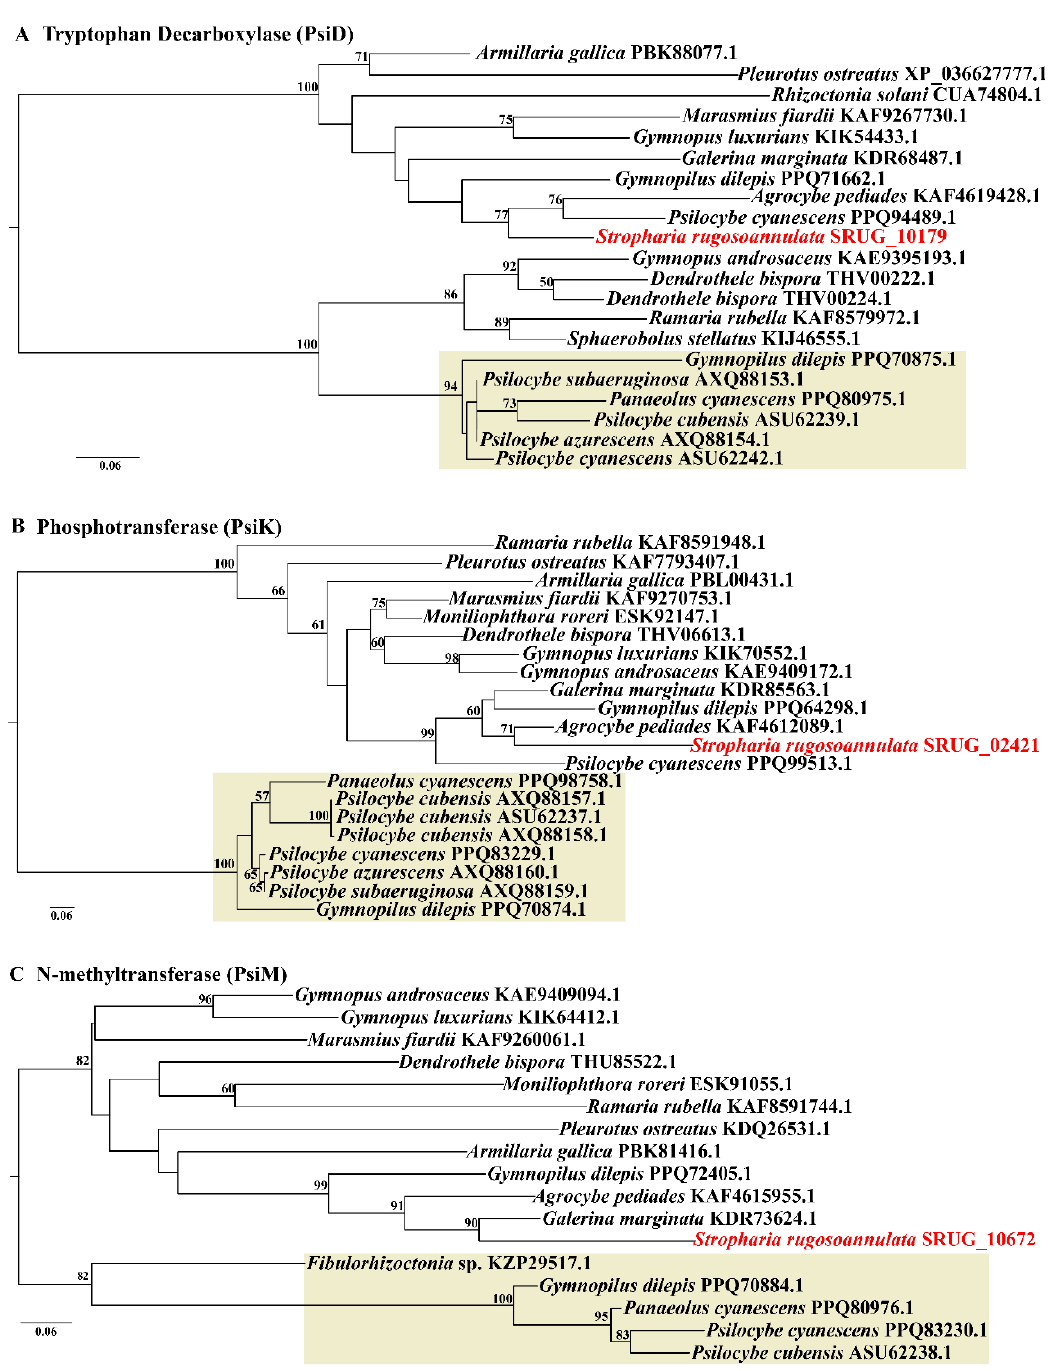
Figure 6. RAxML phylogenetic analysis of the key psilocybin biosynthesis enzymes. ( A ) Tryptophan decarboxylase (PsiD); ( B ) phosphotransferase (PsiK); ( C ) N-methyltransferase (PsiM). The known psilocybin biosynthesis enzymes were grouped as a cluster, which is indicated in pale yellow. The red fonts indicated proteins of S. rugosoannulata.